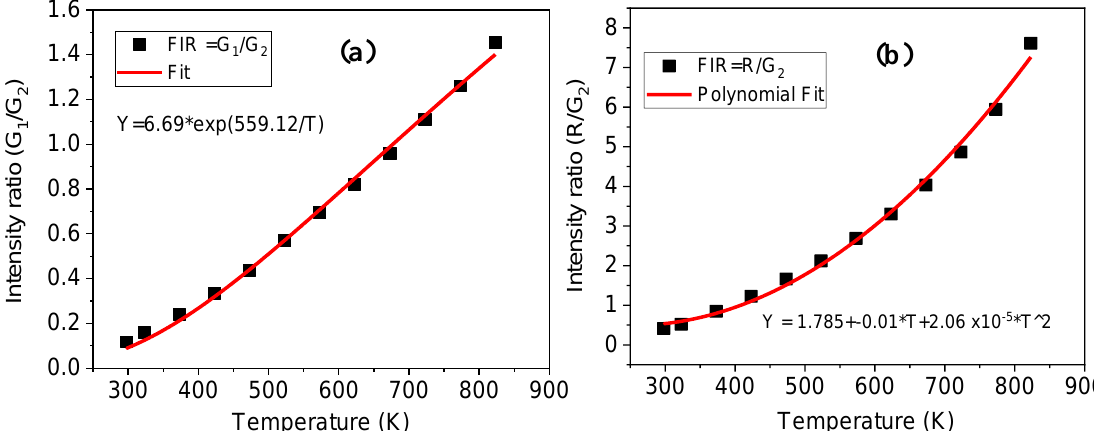
Figure 11. ( a ) Exponential fit of FIR of G 1 /G 2 , and ( b ) polynomial fit of FIR of R/G 2 transitions against temperature for Er-GC sample.